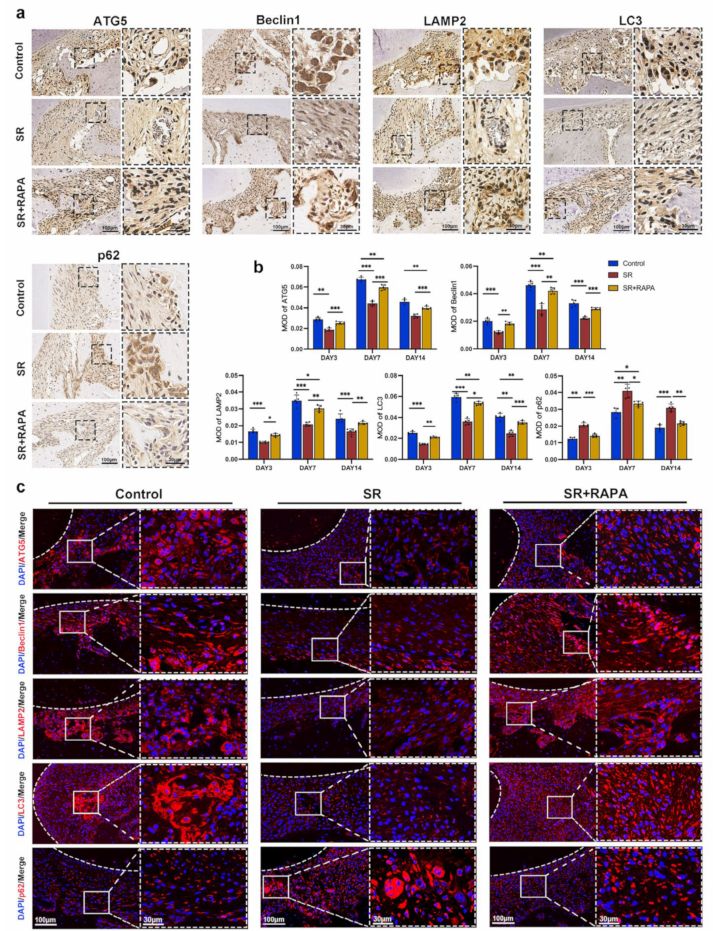
Figure 5. Strontium ranelate regulated the expression of autophagic proteins in rats. ( a ) Immunohis- tochemical staining images of ATG5, Beclin1, LAMP2, LC3, and p62 at the pressure side of the first molars on day 7 in different groups. ( b ) The mean optical density (MOD) of ATG5, Beclin1, LAMP2, LC3, and p62 at the pressure side of the first molars on days 3, 7, and 14 in different groups. (n = 5, mean ± SD, * p < 0.05, ** p < 0.01, *** p < 0.001). ( c ) Immunofluorescence staining images of ATG5, Beclin1, LAMP2, LC3, and p62 at the pressure side of the first molars on day 7 in different groups. The white dashed lines indicate the margin of the tooth